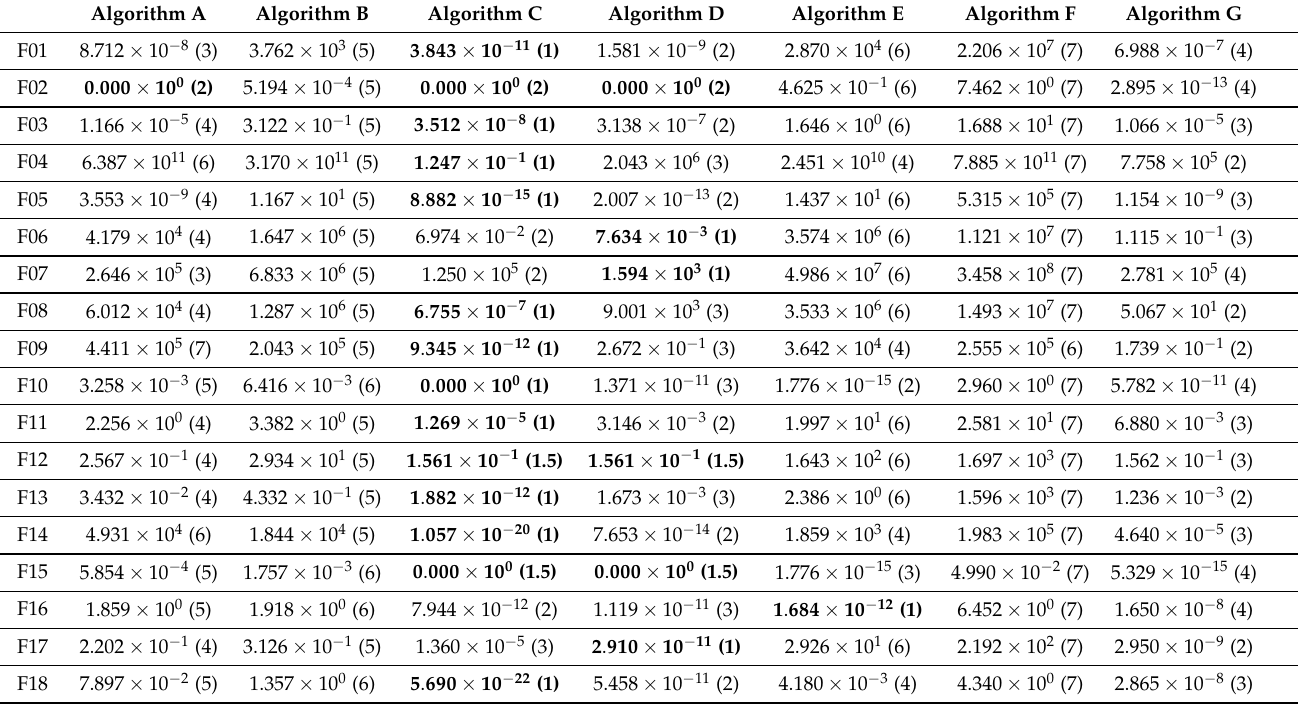
Table 3. Quantiles Q 0.50 of solution quality with corresponding